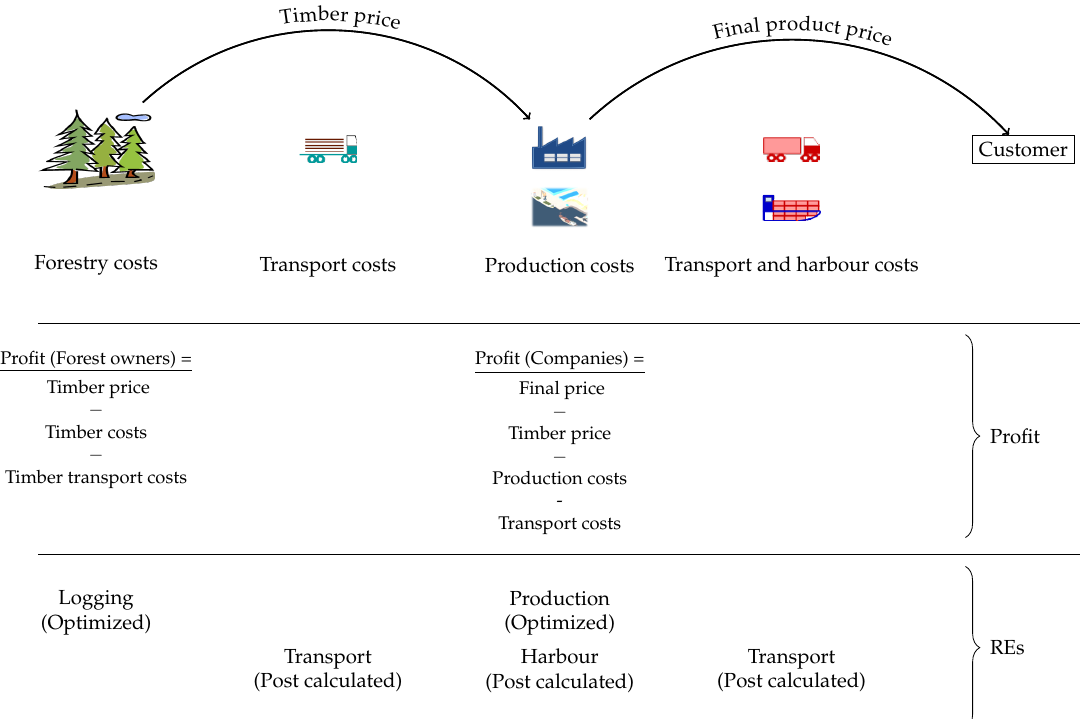
Figure 2. Activities included in VC profit and RE optimization or post